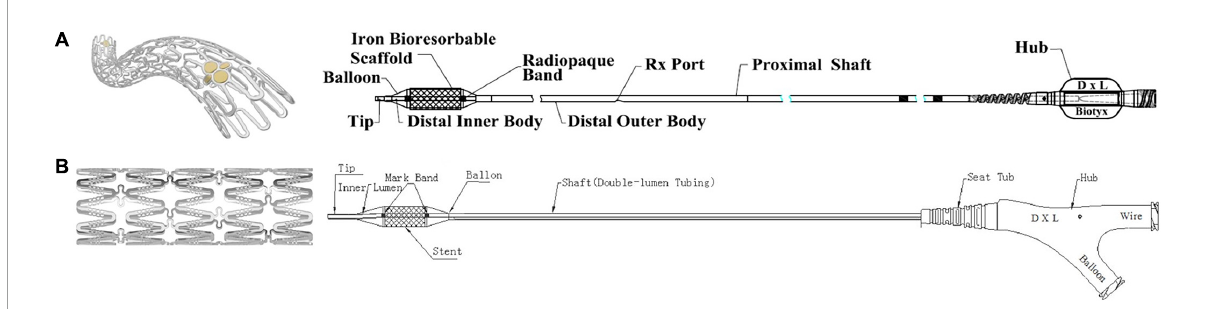
FIGURE1 Lifetech iron-based bioresorbable scaffold stent and angioplasty catheter. (A) Delivery system for stent diameters 2.25–4.0 mm. (B) Delivery system for stent diameters 5.0–10.0 mm.